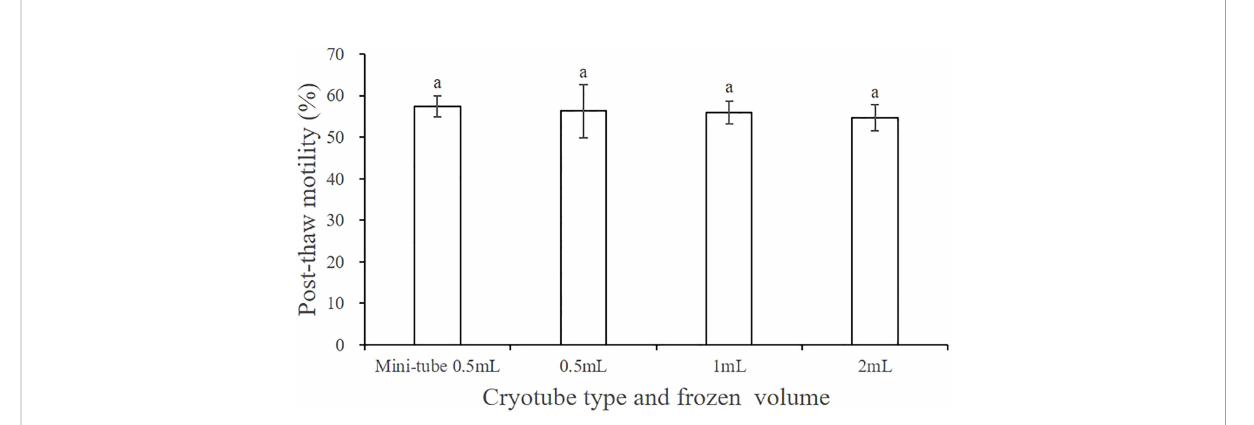
FIGURE 7 Effect of the cryotube types and frozen storage volume on the post-thaw motility of A. japonicus spermatozoa. Data are presented as the means ± SE (n = 4). Different letters indicate signi fi cant differences (P < 0.05). Data were not transformed when performing one-way